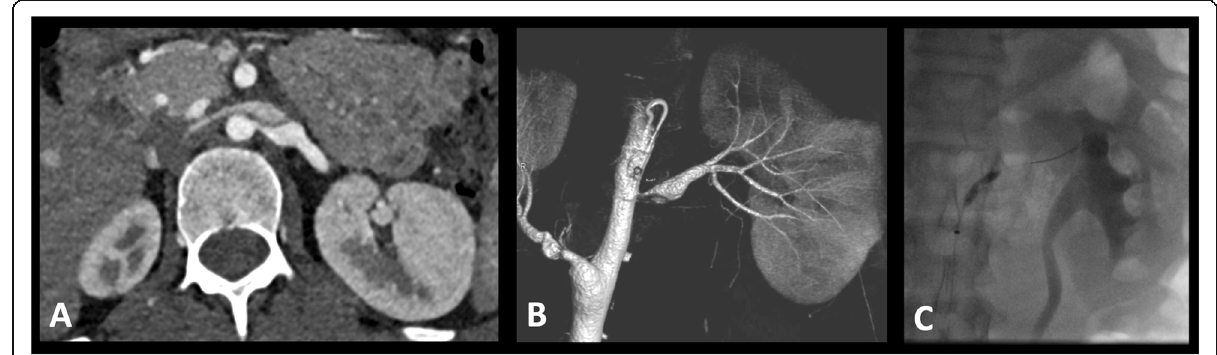
Fig. 1 Renal Artery Stenosis Angioplasty. a Axial contrast enhanced CT angiogram image demonstrating a left renal artery stenosis with post stenotic dilation. b This was confirmed on subsequent rotational angiography and ( c ) at angioplasty by demonstration of a waist on the angioplasty